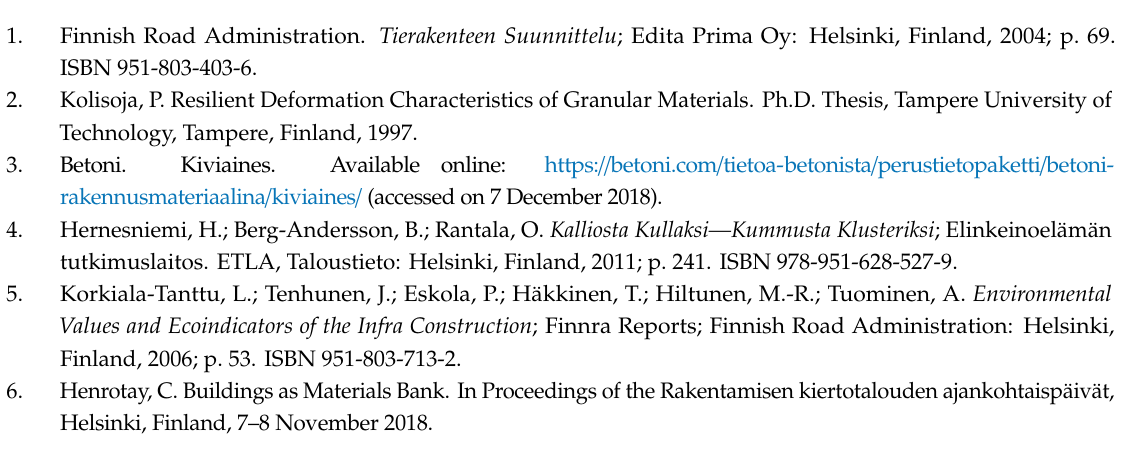
Table S4: Dry density versus final water content from Proctor test, Table S5: Permeability test results, Table S6: Frost heave test